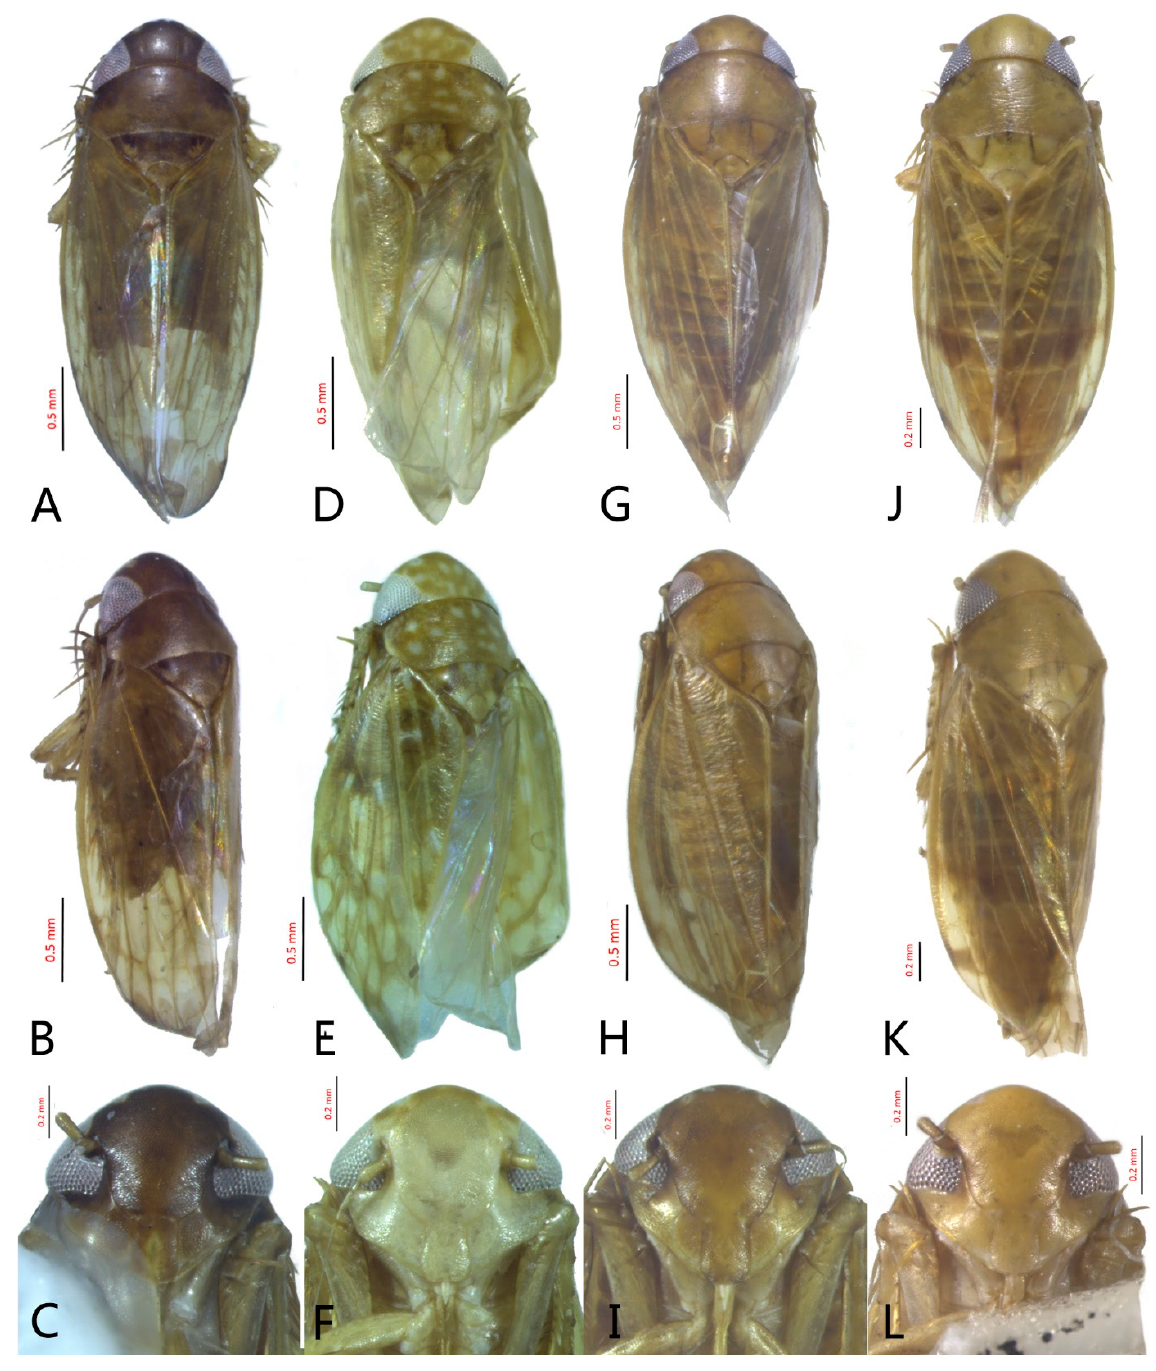
Figure 19. Male habitus of Xestocephalus . ( A – C ) X. recipinams sp. nov.; ( D – F ) X. limipidissimus sp. nov.; ( G – I ) X. dimiprocessus sp. nov.; ( J – L ) X. malleus , sp. nov. ( A , D , G , J ) dorsal view; ( B , E , H , K ) laterodorsal view; ( C , F , I , L ) face. Male genitalia. Pygofer in lateral view higher than long, tapered to rounded caudal margin, many macrosetae on posterior half, with two distinct triangular dilations along ventroposterior margin; internal process of pygofer large hook-like and directed dorsad. Valve short and trapezoidal. Subgenital plate broad, linguiform, apex rounded, with two rows of macrosetae. Style S-shaped, apical dilation of apophysis with outer margin concave and provided with scattered teeth; inner margin with 2 or 3 large spines. Connective cross-shaped, the side arms folded downward. Aedeagus with basal apodeme shorter and broader than shaft, with pair of long processes arising near junction with shaft